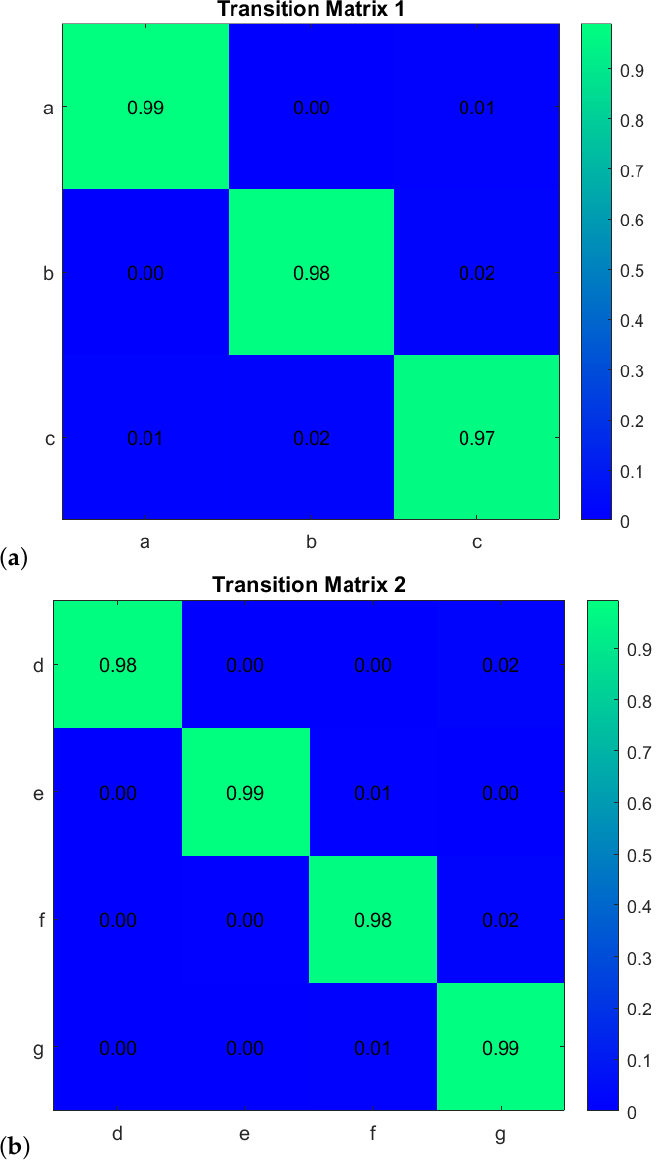
Figure 17. Transition probability matrices obtained from the model M 1 for ( a ) agent 1 ( b ) agent 2 . The joint vocabulary of model M 1 is represented in Figure 18. The edges shown in black are the ones that could find mapping with the graphs produced of the initial model ( M 0 ). The orange edges are newly generated and belong to the detected anomaly. Each of the edges is given a unique label and is summarized in Table 2. The node pairs represented by red in column 3 of Table 2 belong to the